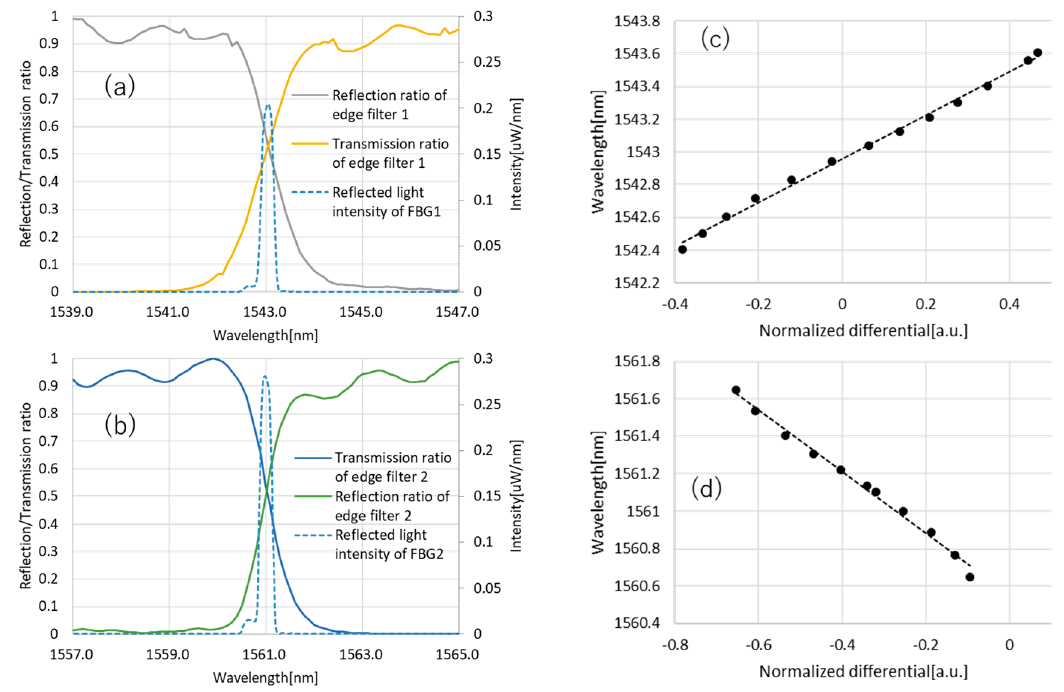
Figure 5. ( a , b ) The spectrums of the ( a ) 1543 and ( b ) 1561 nm-centered edge filters and FBGs. ( c , d ) The results of the Bragg wavelength vs normalized differential signal of the ( c ) 1543 and ( d ) 1561 nm-centered edge filters. Dashed lines indicate the linear approximation of the data. The formulas are λ B = 1.3321 D + 1542.9567 and λ B = − 1.6497 D + 1560.5514 for the 1543 and 1561 nm-centered edge filters, respectively.